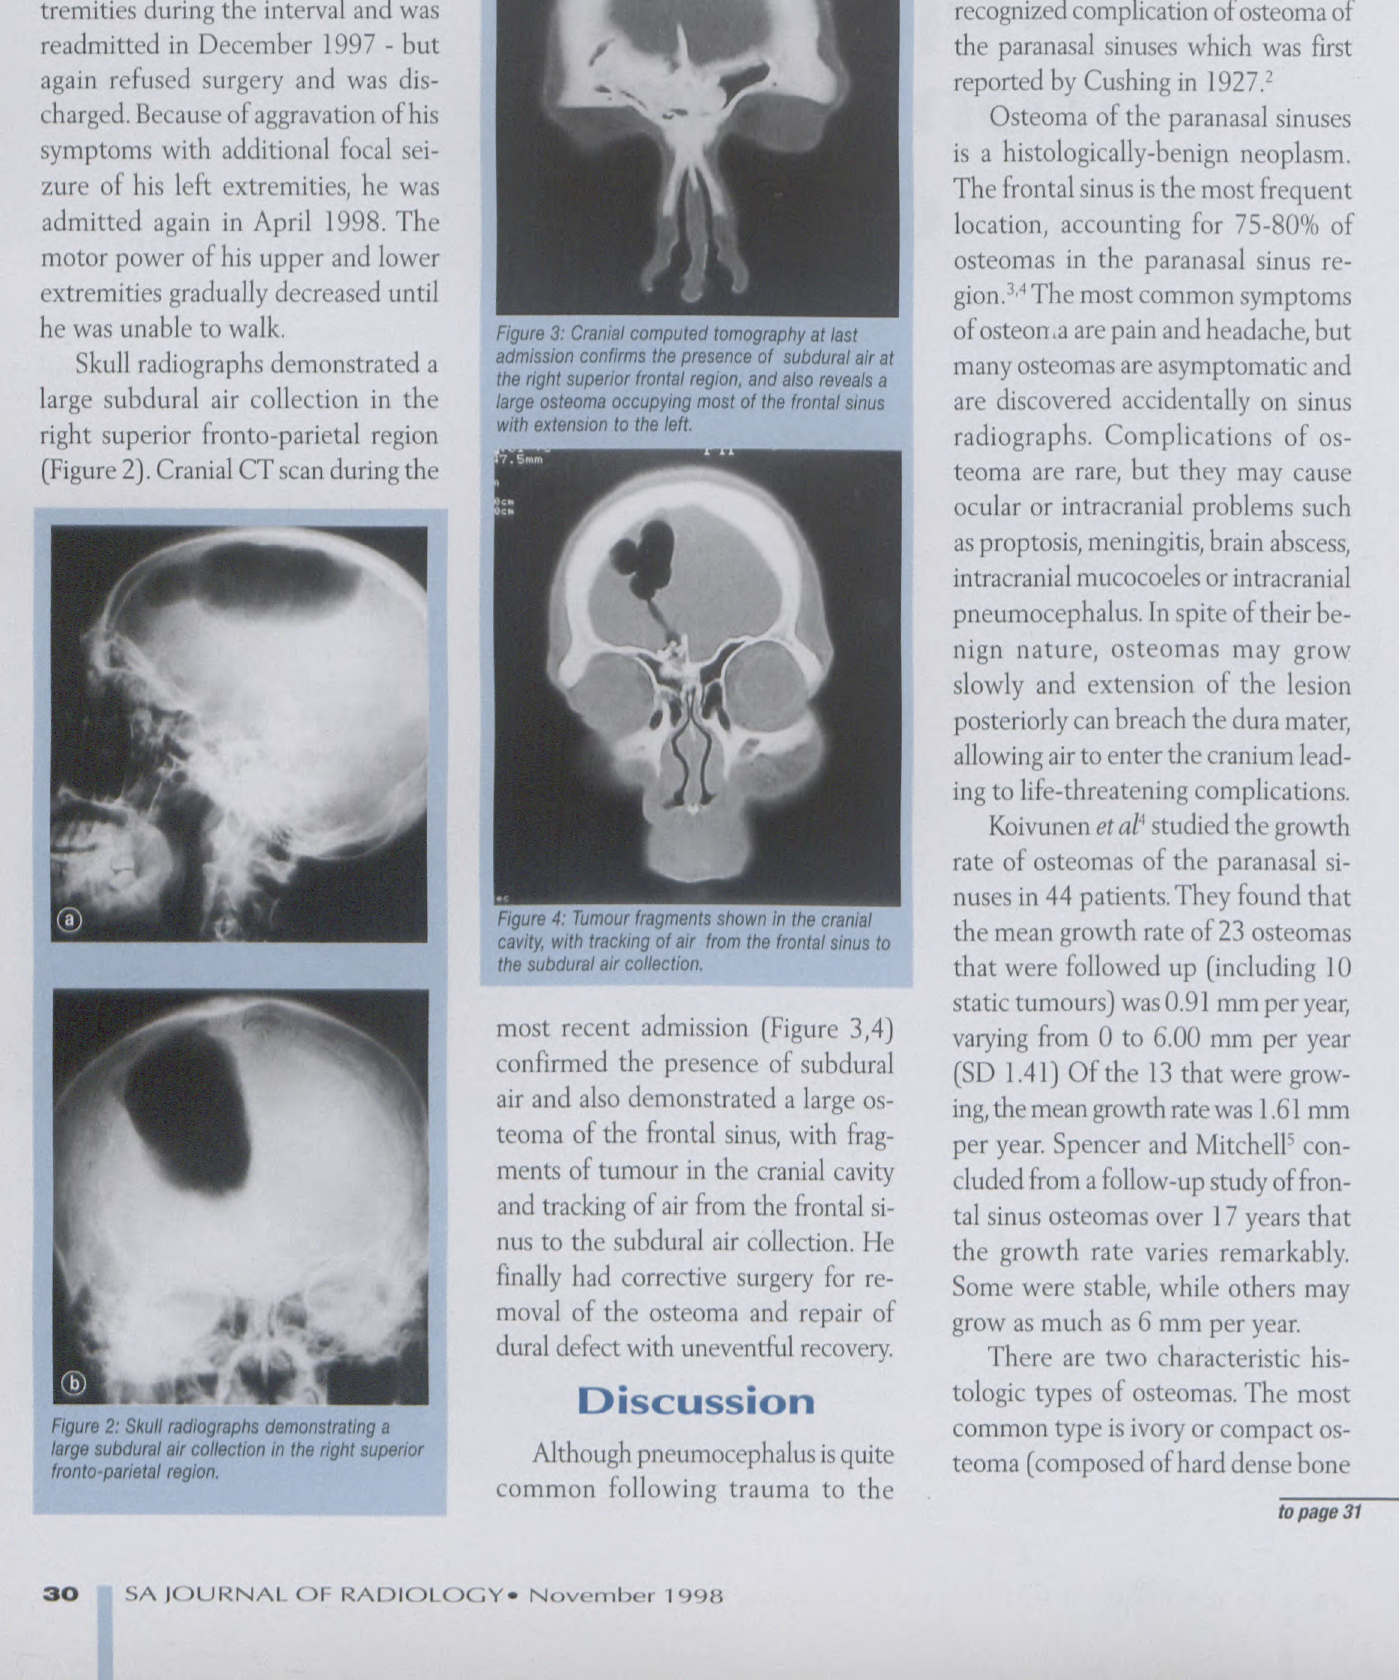
Figure 2: Skul/ radiographs demonstrating a large subdural air col/ectlon In the right superior fronto-parietal region.